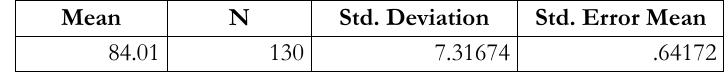
Table 12. Results of the Average Post-test Reasoning